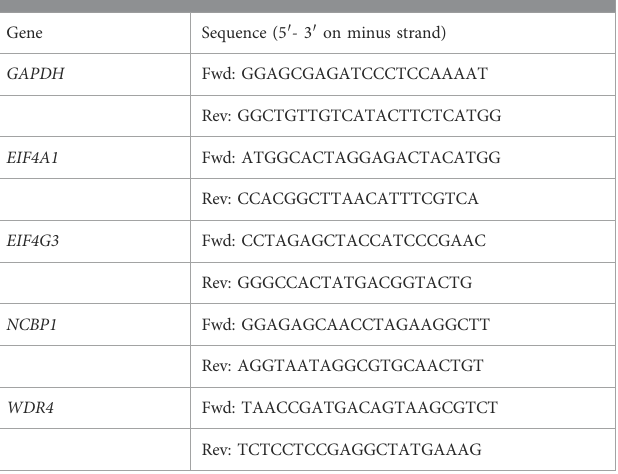
TABLE 1 Primer sequences of